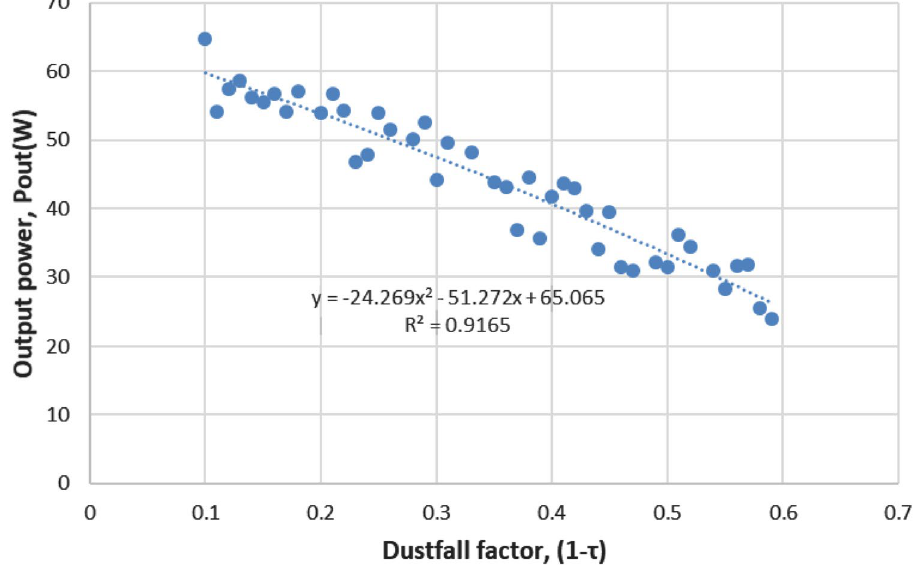
Fig. 5 Simulation result—out- put power ( P out ) against dust- fall factor ( 1 − 𝜏 ) , a nonlinear relationship between the two